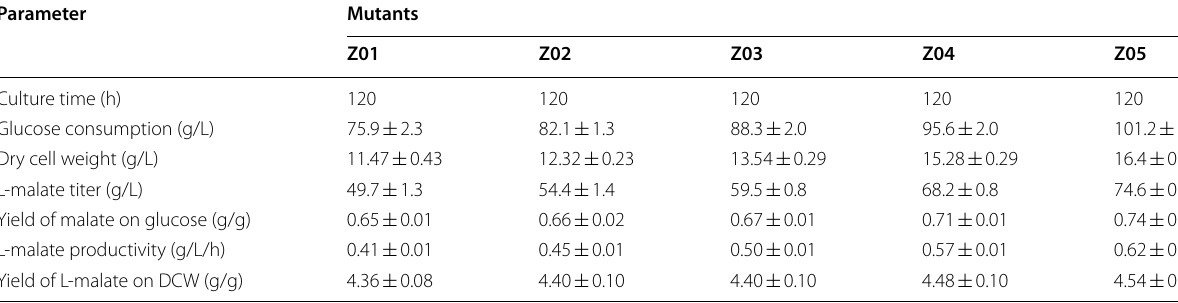
The numbers stated are means of three individual experiments